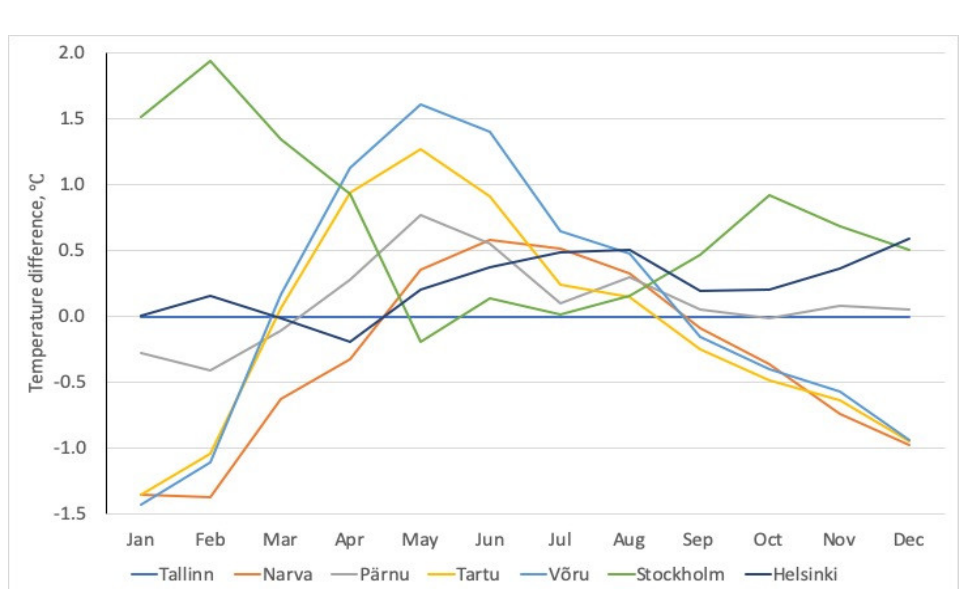
Figure 9. The difference of average monthly air temperatures from surface air temperatures in Tallinn from 2005 to 2019.